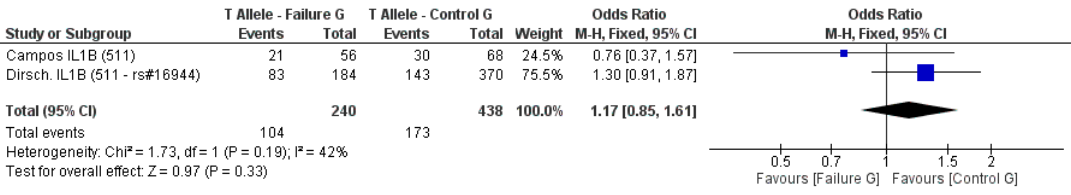
Figure 2. Odds ratio (OR) and forest plot for the prevalence of IL1B-C511 allele in the failure group (at least one implant failure) vs. control group (without implant failure). The OR of the combined data crossed the line of no difference.